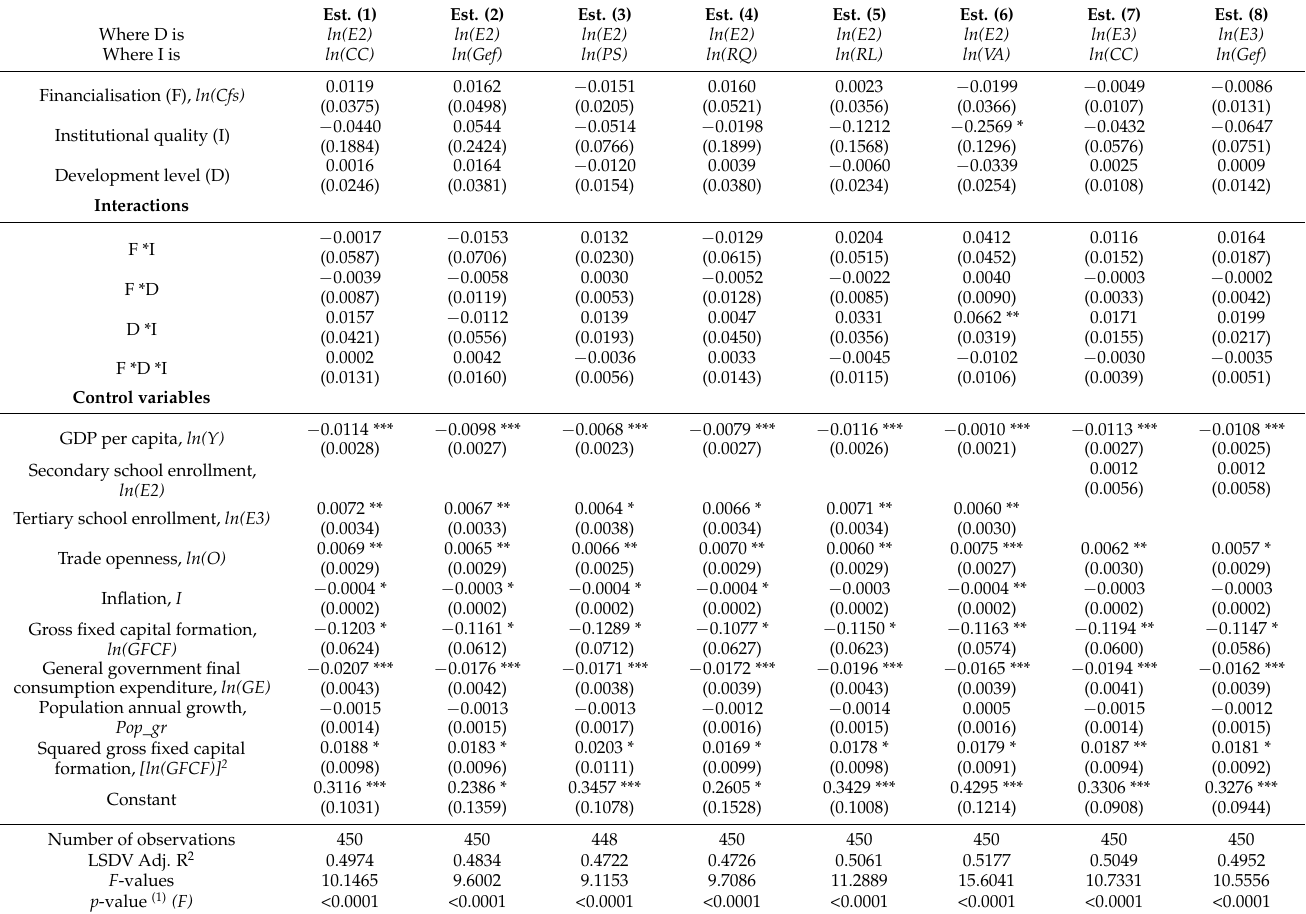
Table A2. LSDV estimates of financialization—ten-year average growth rate